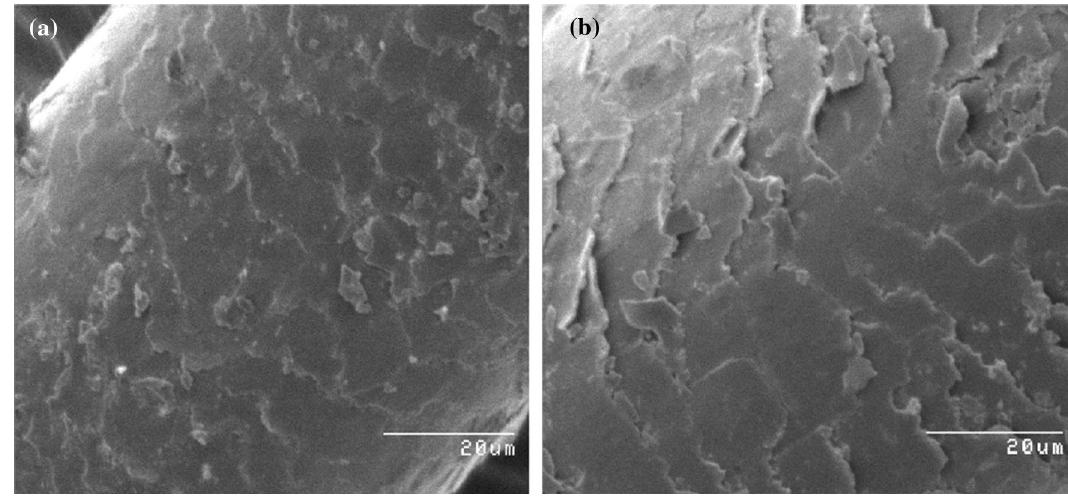
Fig. 1 a Human hair before Cr(VI) adsorption (×1500) and b human hair after Cr(VI) adsorption